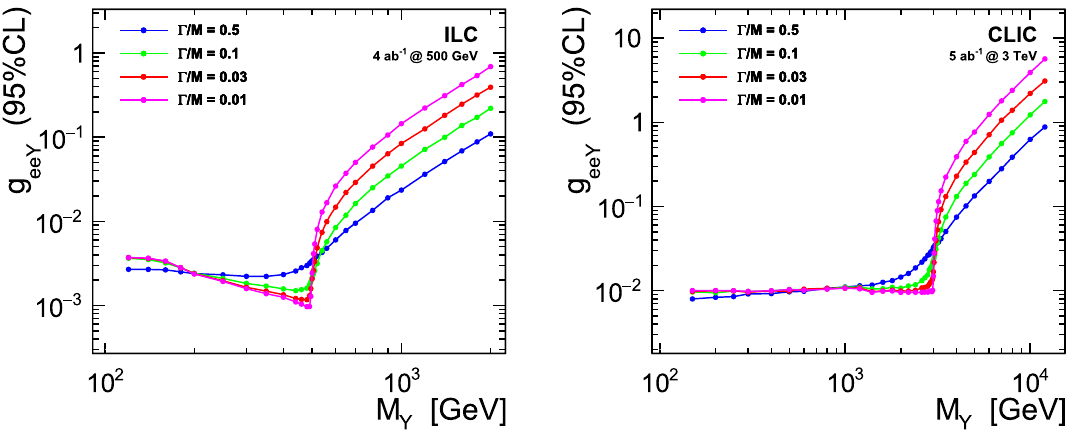
Fig. 14 Limits on the vector mediator coupling to electrons for the ILC running at 500GeV (left) and CLIC running at 3TeV (right) and different fractional mediator widths, as indicated in the plot. Combined limits corresponding to the assumed running scenarios are presented with systematic uncertainties taken into account